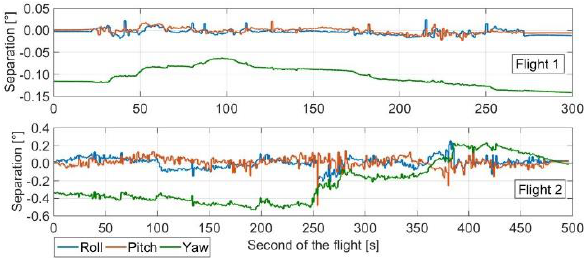
Figure 4. Distribution of point 3D position error in Velodyne HDL-32E swath caused by typical errors of used scanner and navigational sensors (25 m flying height over flat terrain).